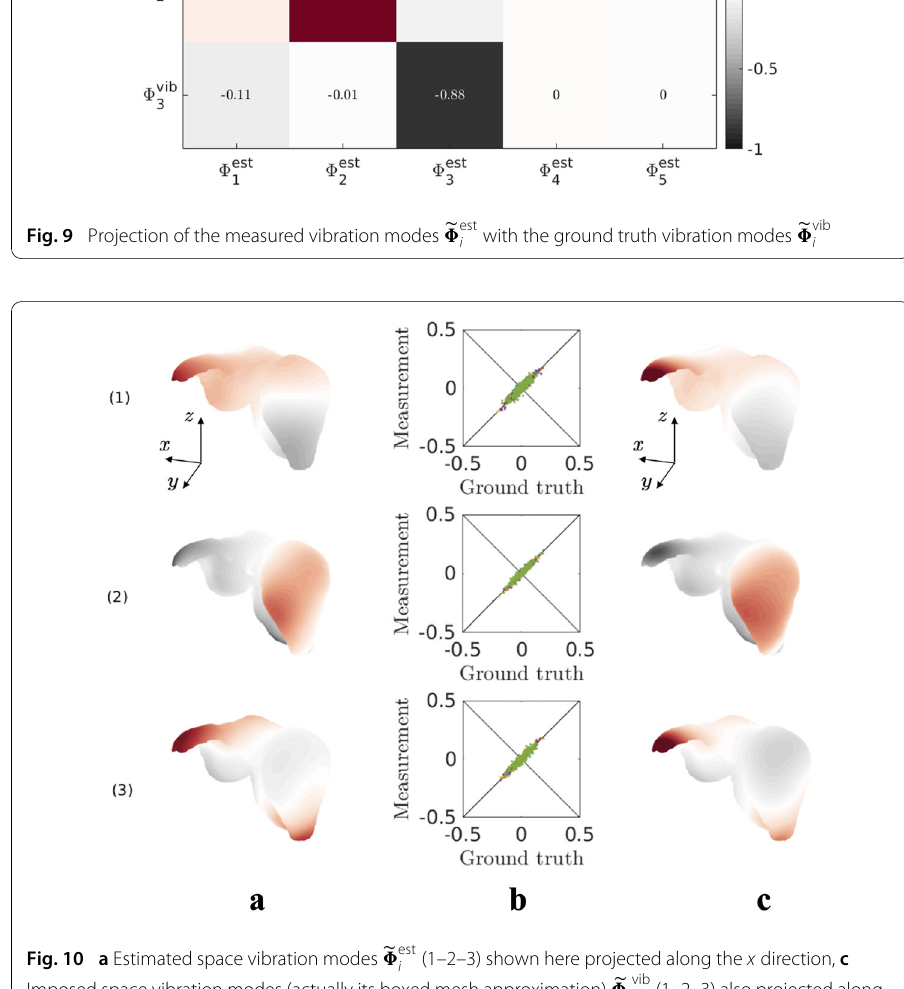
Fig. 10 a Estimated space vibration modes (cid:20) (cid:2) est i (1–2–3) shown here projected along the x direction, c Imposed space vibration modes (actually its boxed mesh approximation) (cid:20) (cid:2) i vib (1–2–3) also projected